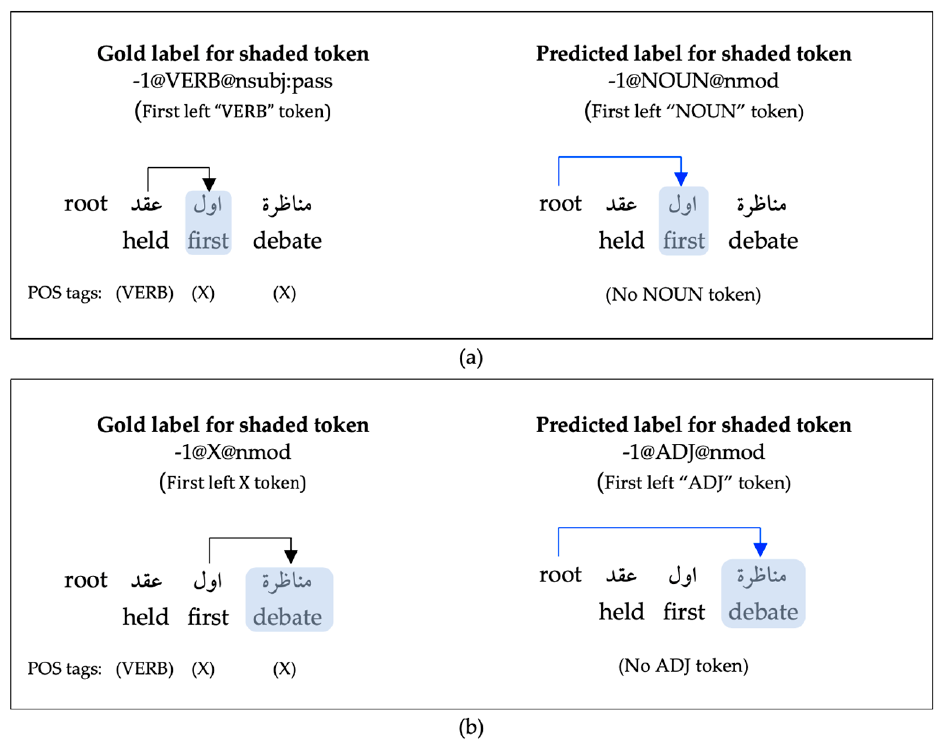
Figure 8. Syntactic label prediction of two tokens (in ( a , b )) with inaccurate POS annotation in test example on